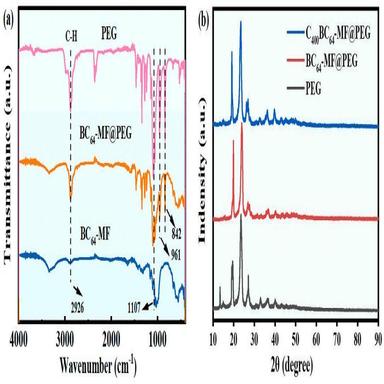
(a) FTIR spectra of PEG, BC64-MF and BC64-MF@PEG; (b) XRD patterns of PEG, BC64-MF@PEG, and C400BC64-MF@PEG.